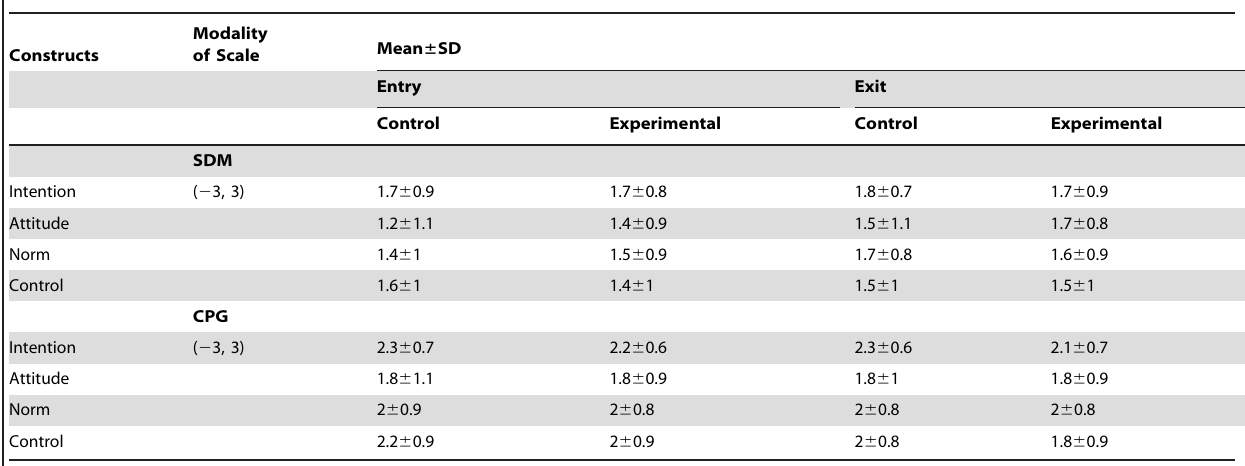
Table 2. Mean scores for constructs.